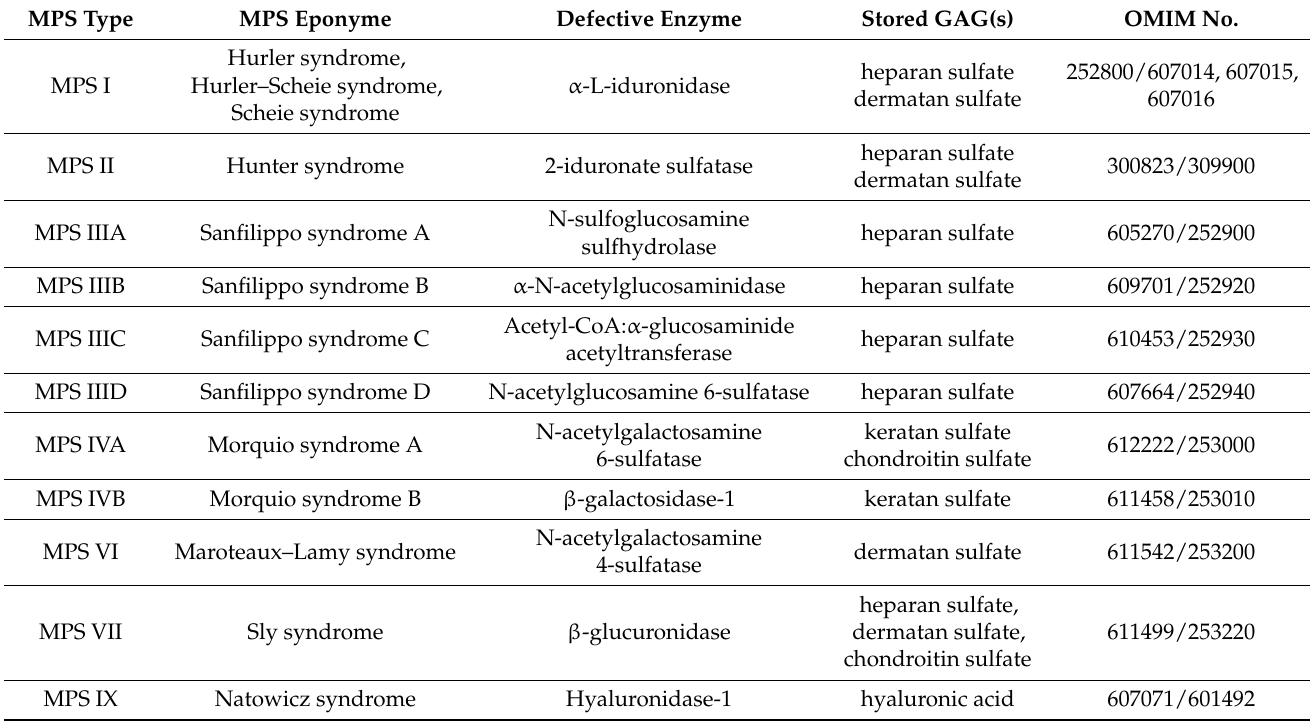
Table 1. Characteristics of types/subtypes of